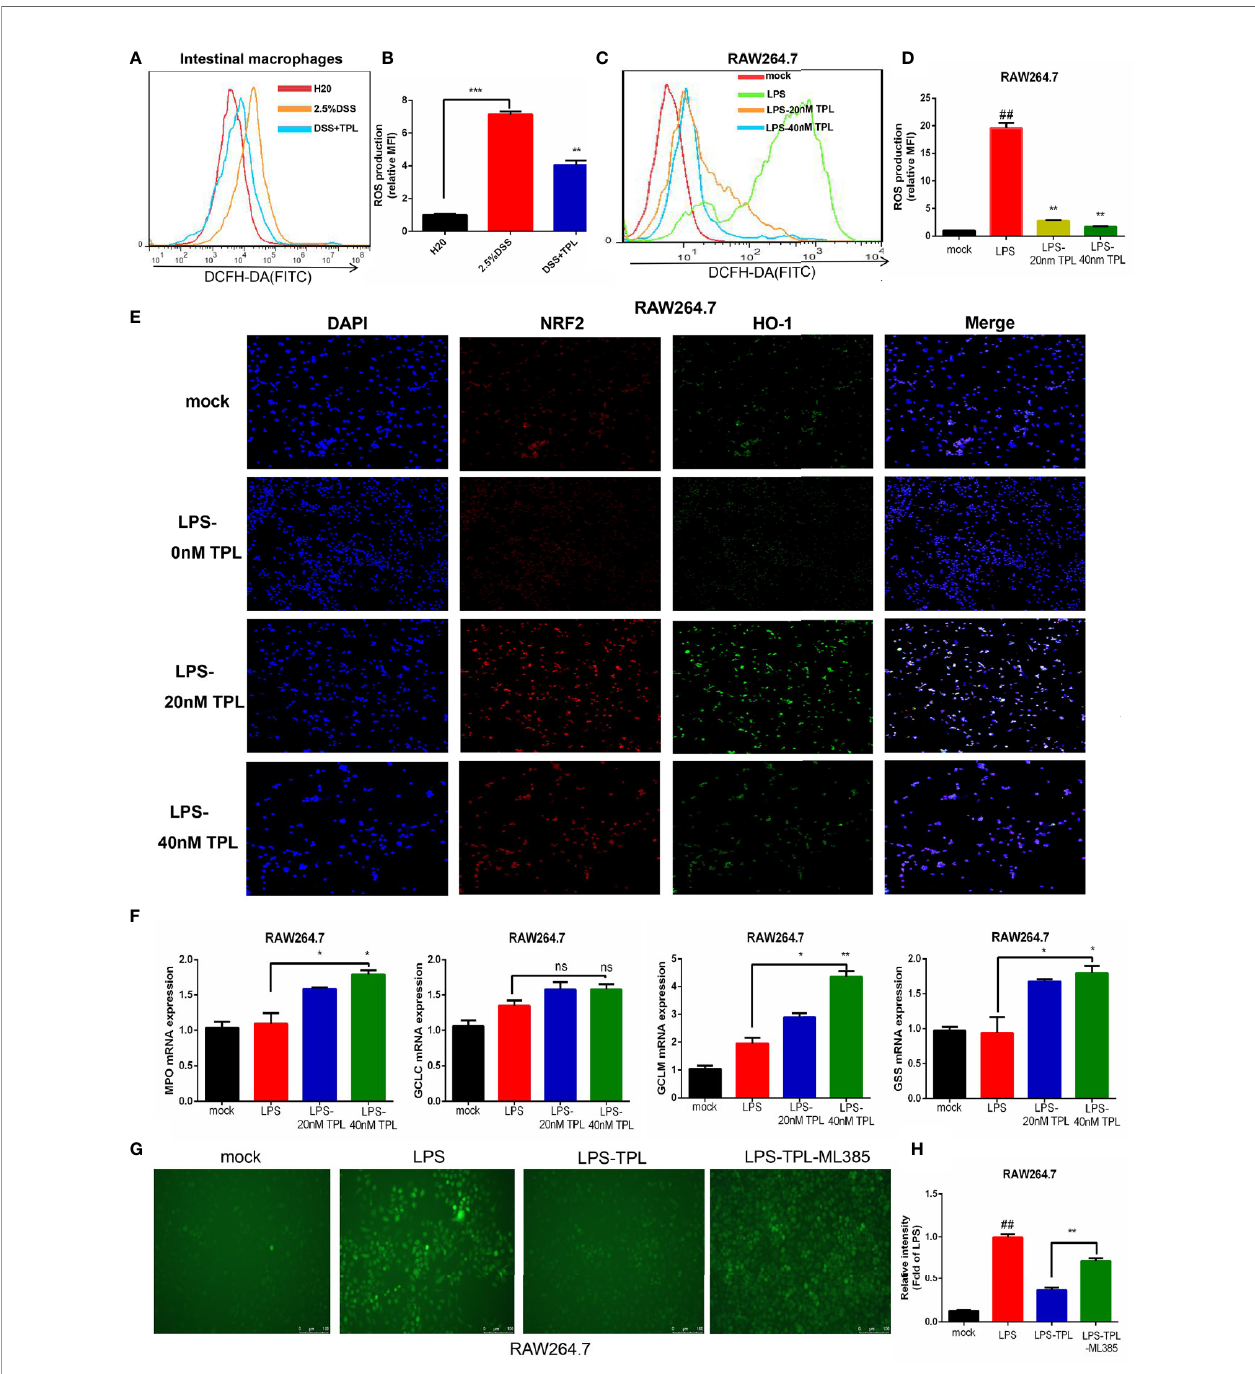
FIGURE 3 | Triptolide treatment decreased the generation of reactive oxygen species (ROS) by activating NRF2/HO-1 signaling cascades. RAW 264.7 macrophages were treated with 1,000 ng/ml LPS with 0 – 40 nM triptolide for 24 h. (A, B) Flow cytometry was performed to determine the generation of ROS in intestinal macrophages in DSS-induced mice colitis. (C, D) The DCFH-DA probe was used to measure the ROS generation in RAW264.7 cells by fl ow cytometry. (E) Immuno fl uorescence assays were performed to detect the cytoplasmic and nuclear NRF2 and HO-1 levels in RAW 264.7 macrophages. (F) RT-qPCR was used to detect the mRNA expression of MPO , Gss , Gclc , and Gclm in RAW 264.7 macrophages. (G, H) The ROS inhibition effect of triptolide was signi fi cantly reversed by the ML385 in LPS-activated macrophages. b -actin or glyceraldehyde 3-phosphate dehydrogenase served as an internal control. Data are shown as the mean ± SD of at least three independent experiments. *P < 0.05; **P < 0.01; ***P < 0.001; and ns means no signi fi cance. ## means the statistical difference between the results of the LPS group and the mock group was P <